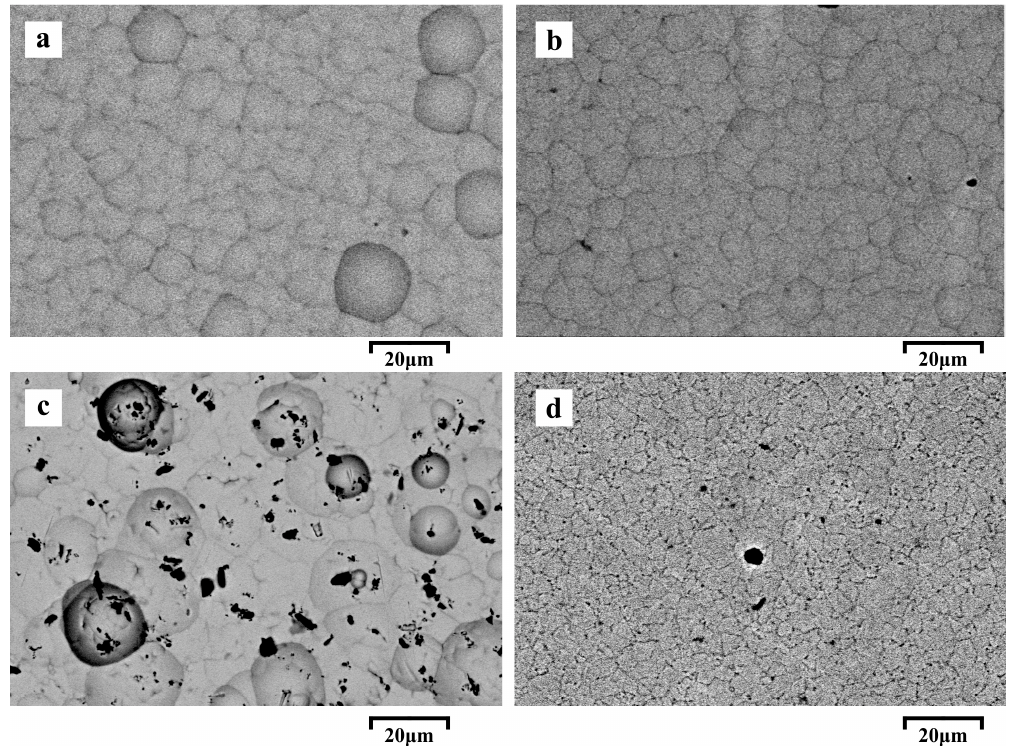
Figure 2. Scanning electron microscope pictures the different electrodeposited coating systems produced at 50% duty cycle, 100 Hz with and without heat treatment (HT) at 400 °C.